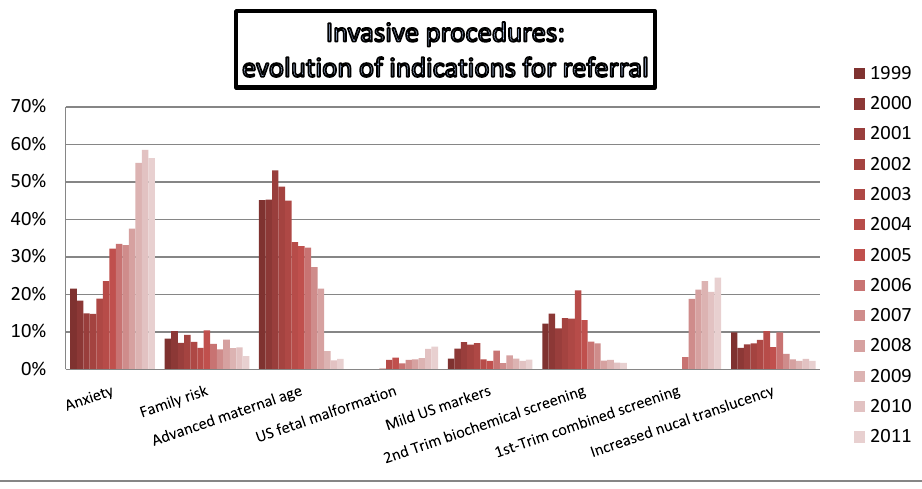
Figure 7. Annual distribution of indications for referral in the chromosomal abnormalities series. Chromosomal abnormalities: Annual distribution of indications for